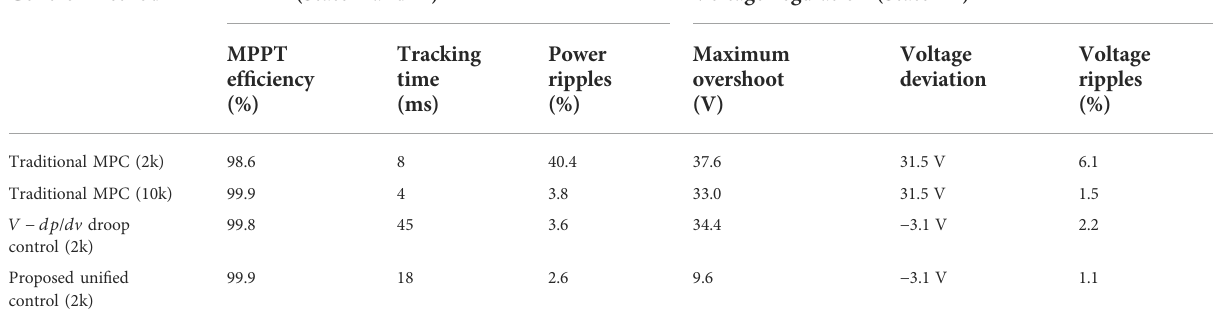
TABLE 3 MPPT and voltage regulation dynamic responses with different